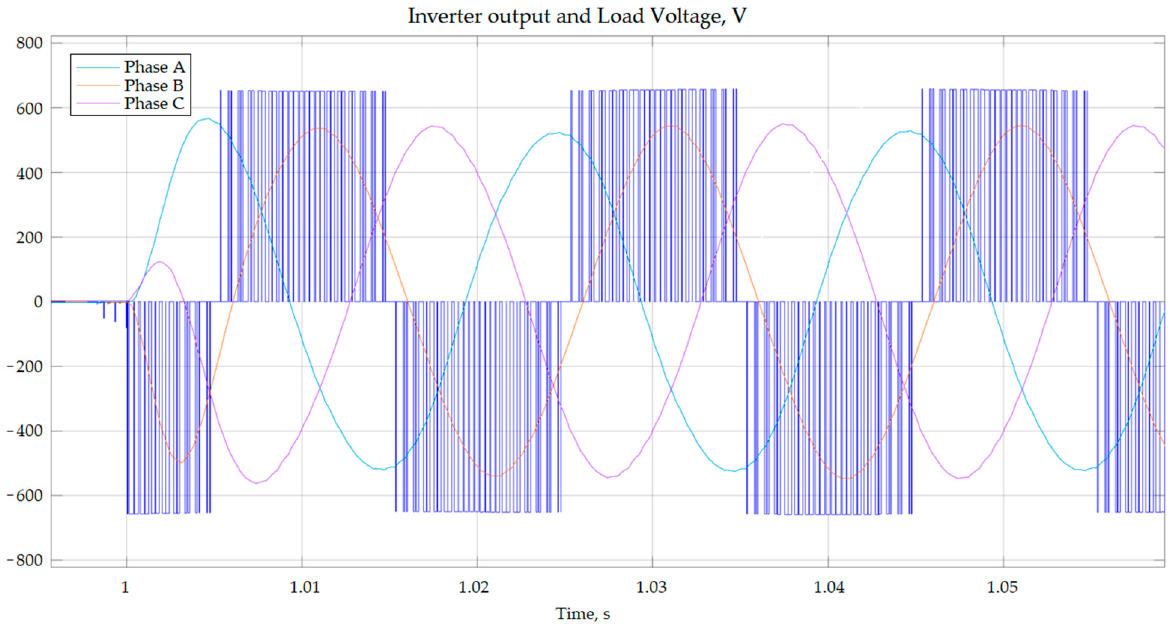
Figure 10. Oscillograms of the line voltage at the inverter output and the load line voltage.